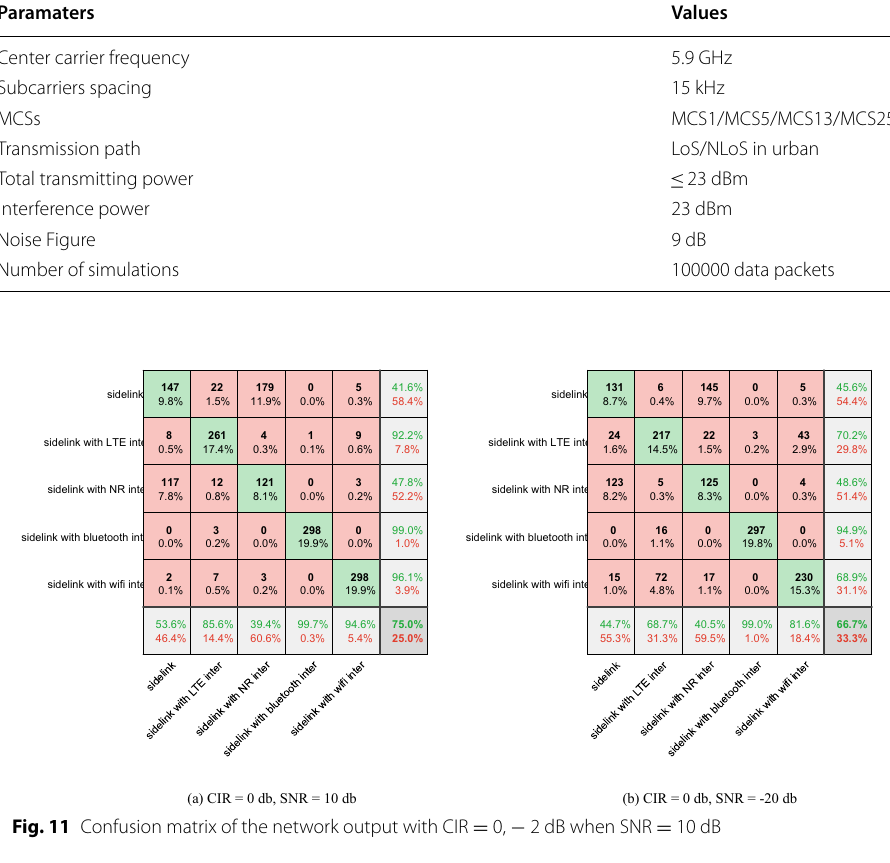
0, 2 dB when SNR = −